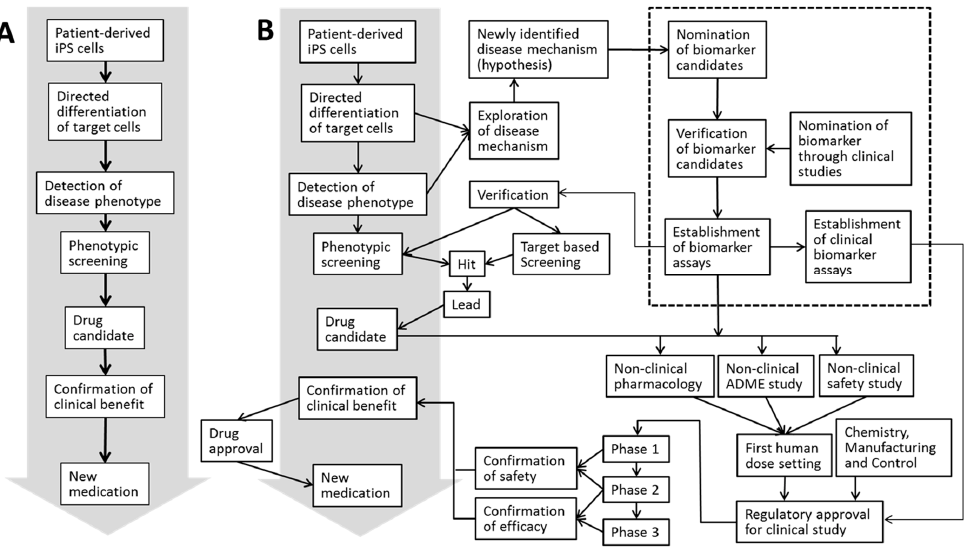
Figure 1. Schematic illustration of the development process from patient-derived induced pluripotent stem (iPS) cells to a new medication. Outline ( A ) and addition of the processes necessary from both the scientific and regulatory perspectives. ( B ) Biomarker strategy is highlighted by the dotted box.